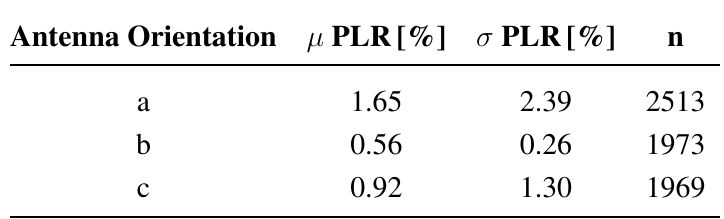
Table 4. Statistical analysis of the antenna orientation dependency of the packet loss rate. n = the total number of generated